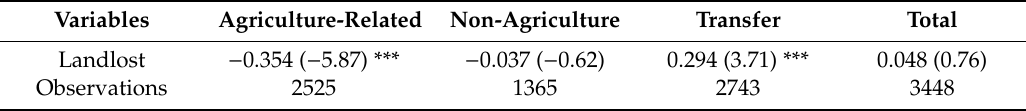
Table 7. Mechanism a ff ecting health status: the e ff ect of the land expropriation on the di ff erent